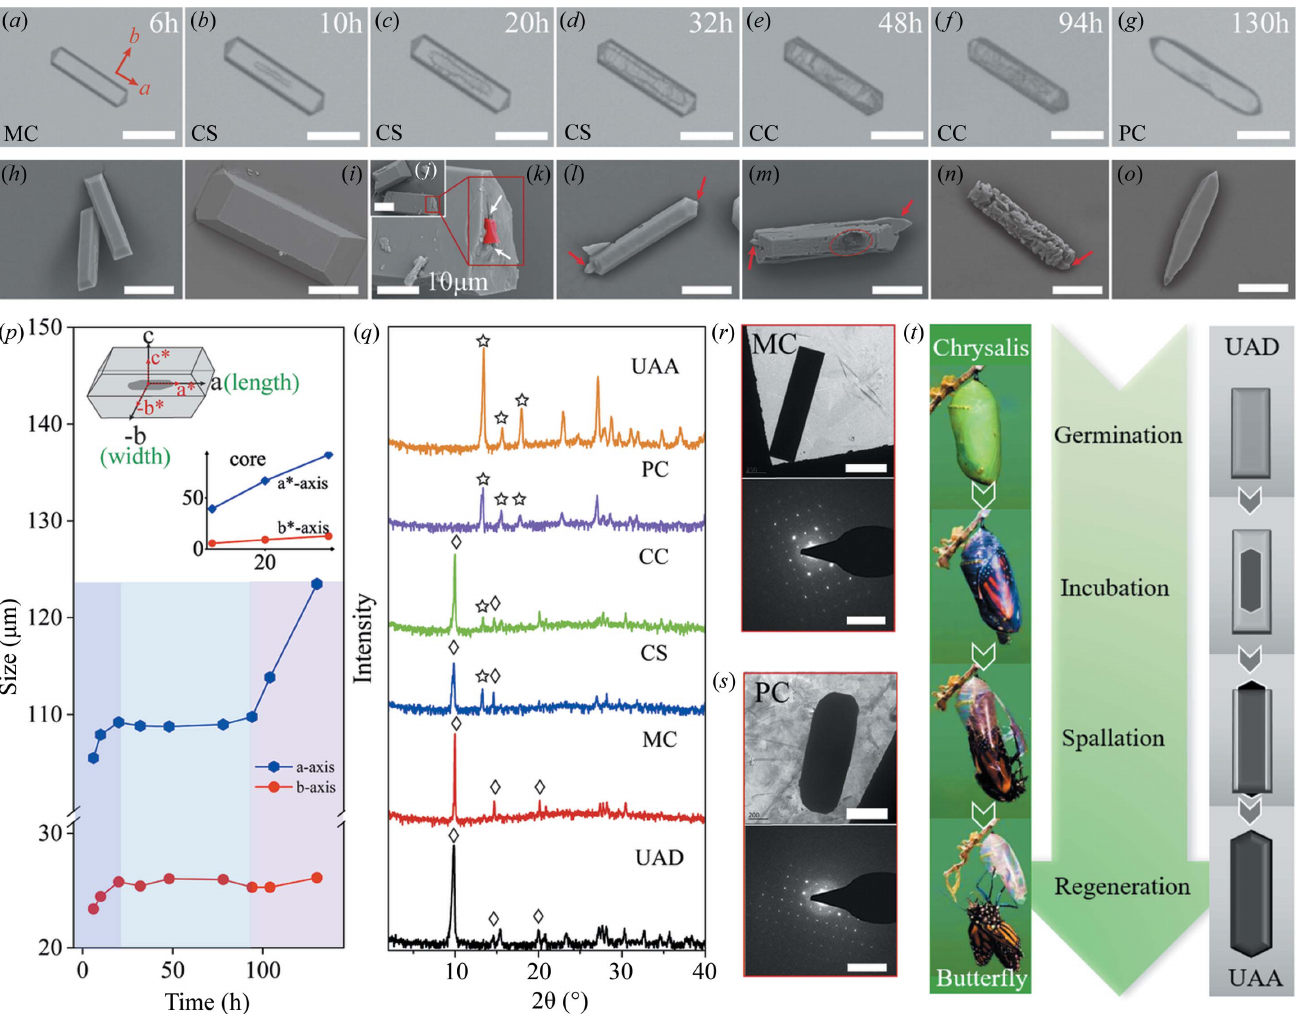
Figure 1 Morphology and structural evolutionary processes of the core-shell phase transition. ( a )–( g ) Time-resolved micrographs of a crystal crystallized from a solution containing 6.5 m M UA, hydrochloric acid, water and 0.14 M NaCl at pH 5.5. The scale bar is 50 m m. MC – mother crystal, CS – core-shell crystal, CC –complex crystal, PC – pure crystal. ( h )–( o ) SEM images of the crystal isolated at different stages. The scale bar is 25 m m. ( p ) Size evolution of the length and width of the shell phase (inset, upper left). Schematic representation of a core-shell crystal (inset, upper right). The size evolution of the length and width of the core phase. ( q ) PXRD patterns of the crystal obtained at different stages. ( r ) and ( s ) TEM images and SAED patterns of MC initially formed and the resultant PC. The scale bar is 400 nm in the TEM images and 5 nm (cid:5) 1 in the SAED patterns. ( t ) Schematic illustration of the morphology evolution of the crystal at different